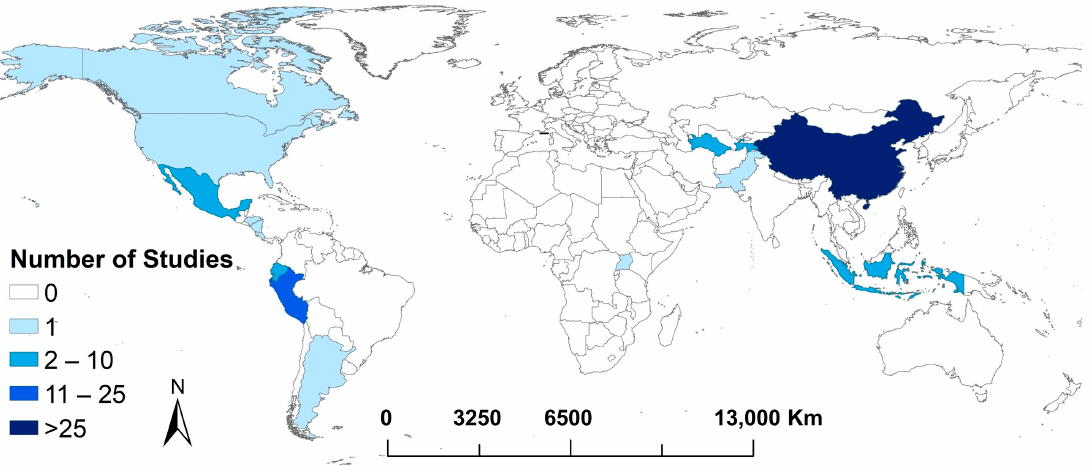
Figure 3. Number of irrigation-induced landslides documented within the Chinese, English, and Spanish literature, by country.